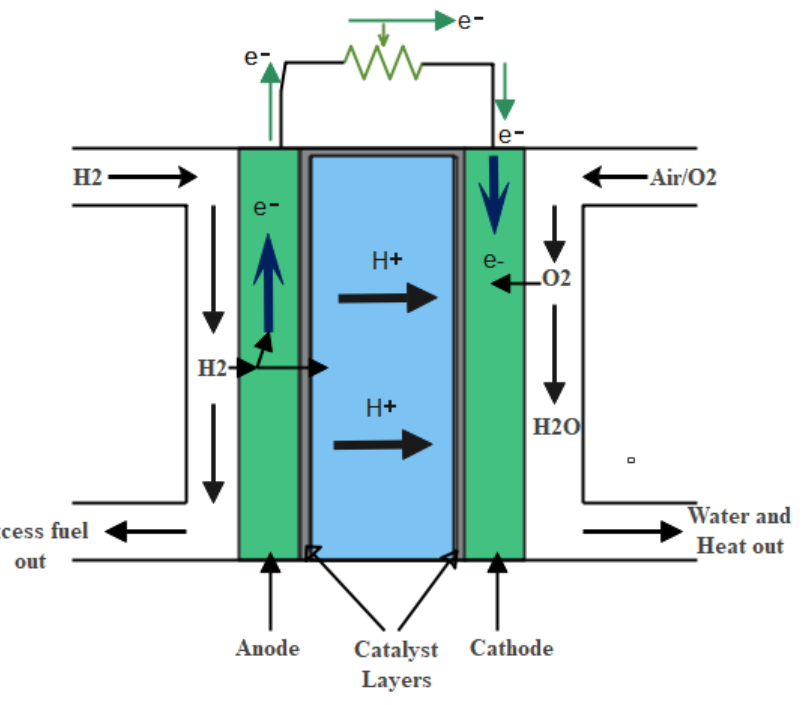
Figure 1. The schematic configuration of the PEMFC [47].